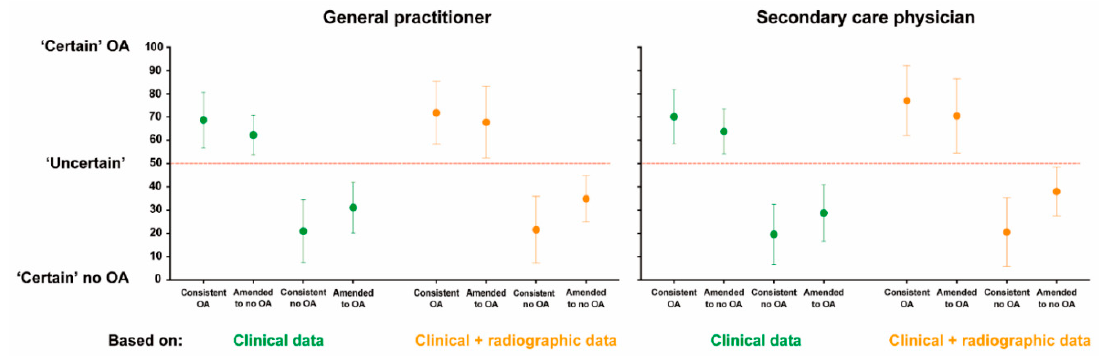
Figure 3. Certainty scores of four subgroups before and after viewing radiographic data (means and standard deviations).